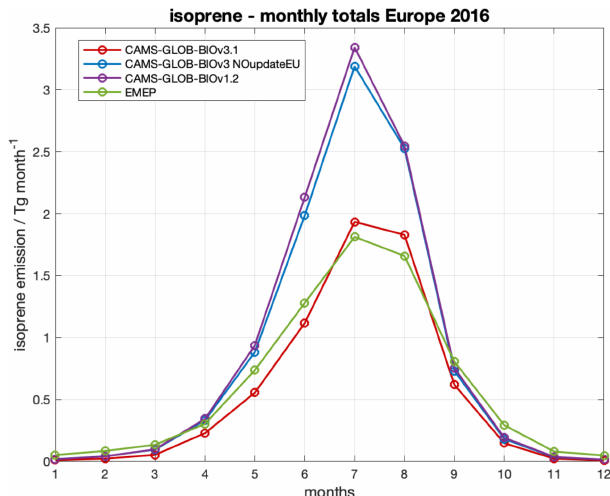
Figure 7. Comparison of isoprene global annual totals from CAMS-GLOB-BIOv3.1 (black), CAMS-GLOB-BIOv3.0 (red), CAMS-GLOB-BIOv1.2 (orange) and other available inventories within the 2000–2019